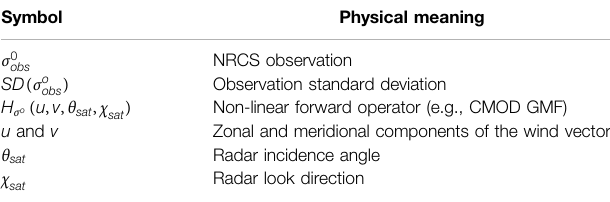
TABLE 1 | The physical meanings of the symbols in Eq. 3